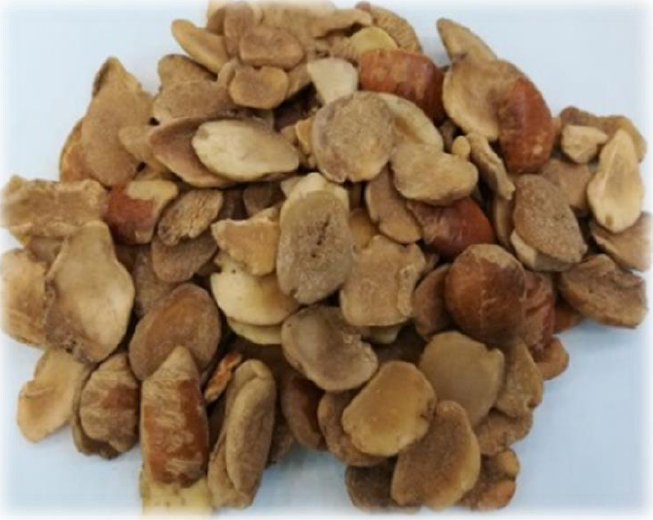
Figure 1. Irvingia gabonensis almonds.